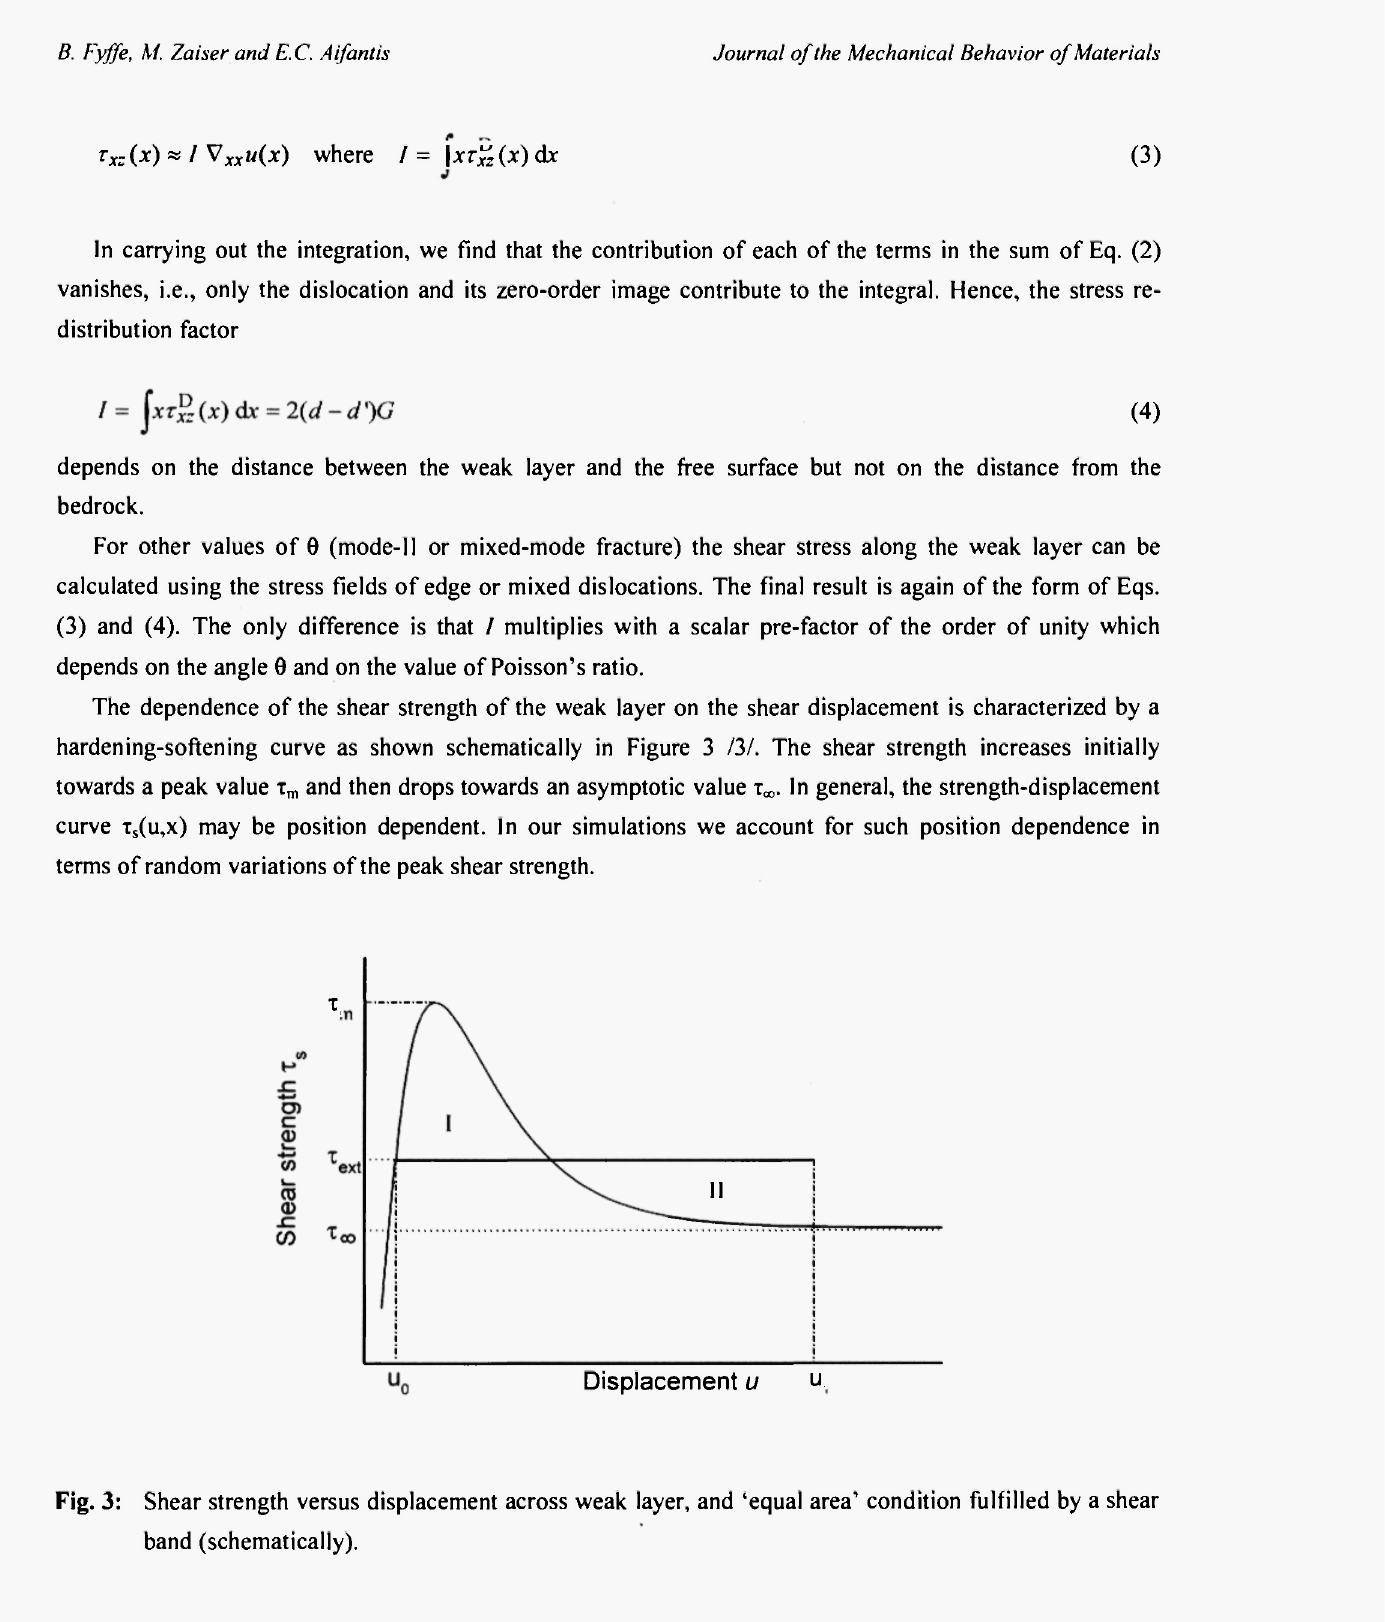
Fig. 3: Shear strength versus displacement across weak layer, and 'equal area' condition fulfilled by a shear band